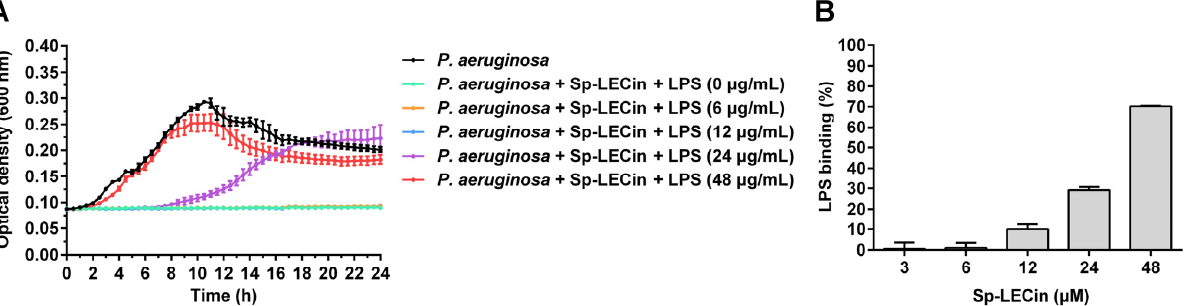
Figure 4. The binding property of Sp-LECin to LPS. ( A ) The Effect of exogenous LPS (0, 6, 12, 24 and 48 μ g/mL) on the antibacterial activity of Sp-LECin (24 μ M) was assessed by measuring the growth curve of P. aeruginosa . The bars indicate the mean ± standard error of mean ( n = 3). ( B ) Determination of the binding property of Sp-LECin to LPS by the LAL assay. The bars indicate the mean ± standard error of mean ( n = 5).